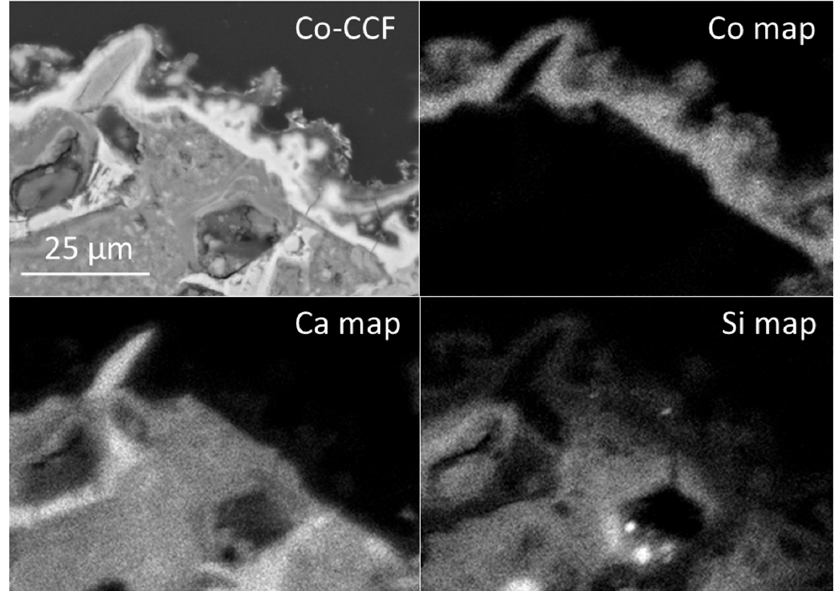
Figure 8. Back-scattered electron micrograph of cross section of cobalt-laden CCF particle and corresponding EDX maps for cobalt, calcium and silicon. All images are of the same sample area.